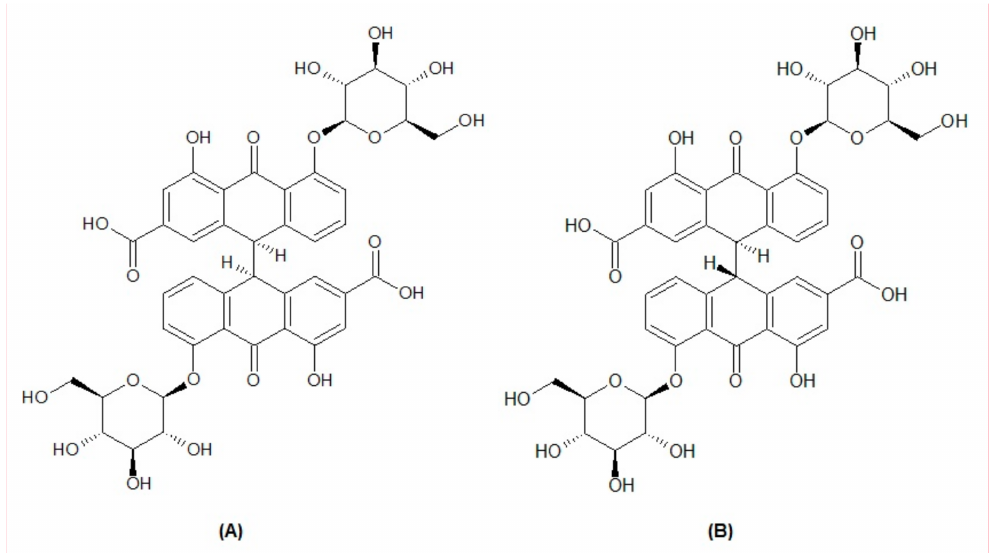
Figure 1. Chemical structure of biomarkers sennoside A ( A ) and sennoside B ( B